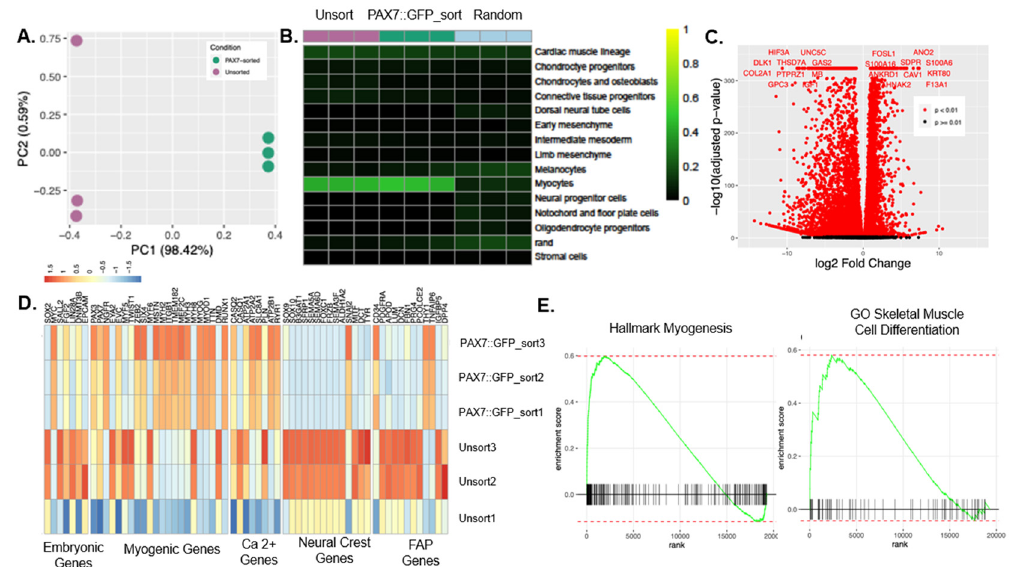
Figure 3. RNA Sequencing elucidates differences between Pax7-sorted and unsorted myogenic progenitors. ( A ) Principal component analysis demonstrates Pax7-sorting selects for a distinct sub-population. ( B ) CellNet/SingleCellNet tool allows for the comparison of sorted and unsorted populations to in vivo cells from mouse organogenesis cell atlas fetal days 9.5–13.5. Pax7-sorted cells show a slightly higher fetal myocyte classification score than unsorted cells. ( C ) Volcano plot shows the distribution of genes more highly expressed in unsorted cells ( left ) and Pax7-sorted cells ( right ). Red dots indicate significantly different expression. Labeled genes are the 12 most significantly differentially expressed. ( D ) Heatmap of key embryonic, myogenic, Ca2+ signaling, and neural crest-related genes expressed in unsorted and sorted populations indicates a higher overall expression of myogenic genes in Pax7-sorted cells and embryonic and neural crest-associated genes in unsorted cells. ( E ) Relevant gene sets enriched in sorted (Hallmark Myogenesis and GO Skeletal Muscle Cell Differentiation).